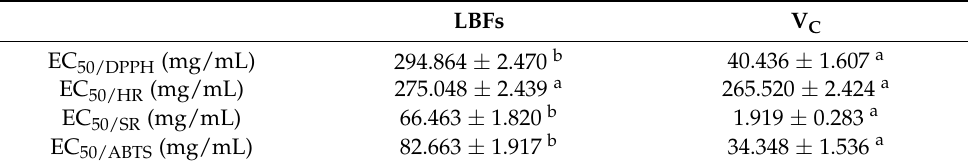
Table 3. EC 50 values of antioxidant activities of the extract of flavonoids from the fruits of Lycium barbarum (LBFs) and V C determined by DPPH free radical scavenging assay, hydroxyl radical (HR) scavenging assay, superoxide radical (SR) scavenging assay, and ABTS radical scavenging assay. Data are shown as the means ± S.D. Data bearing different letters are significantly different ( p <